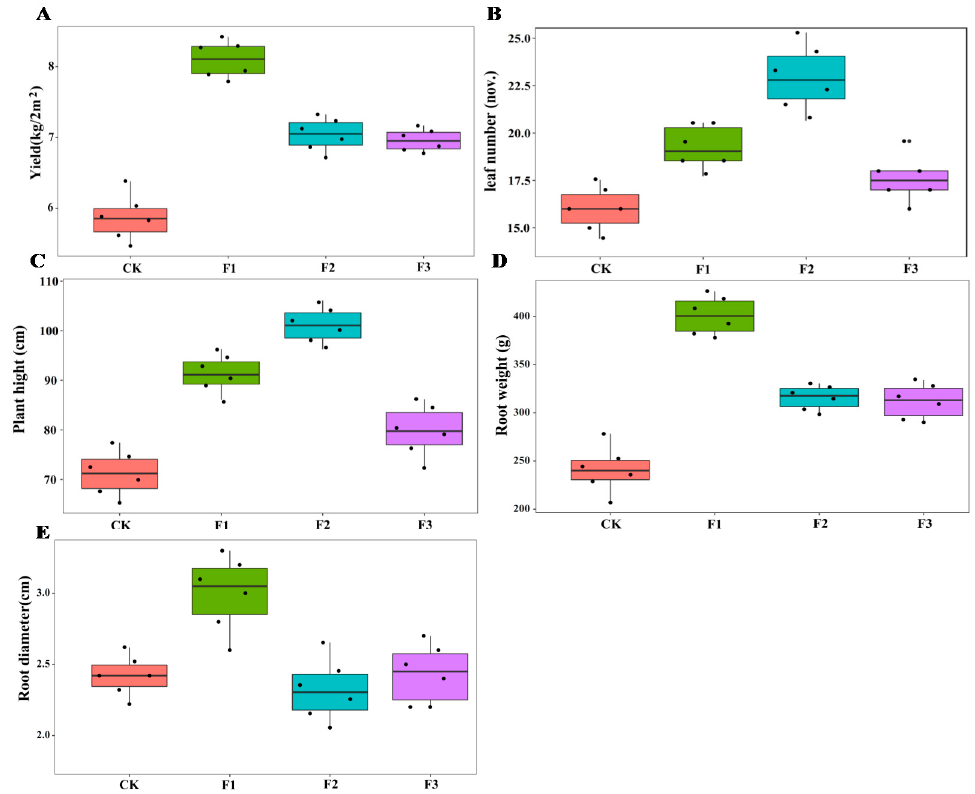
Figure 1. Effect of different foliar fertilizer on the growth parameters of Chinese yam. Yield of yam under different foliar fertilizer treatments ( A ); Leaves number of yam under different foliar fertilizer treatments ( B ); Plant height of yam under different foliar fertilizer treatments ( C ); Root weight of yam under different foliar fertilizer treatments ( D ); Root diameter of yam under different foliar fertilizer treatments ( E ). CK, spray with water; F1, NPK foliar fertilizer; F2, NPK+Fe-Mn-Zn foliar fertilizer; F3, Fe-Mn-Zn foliar fertilizer.